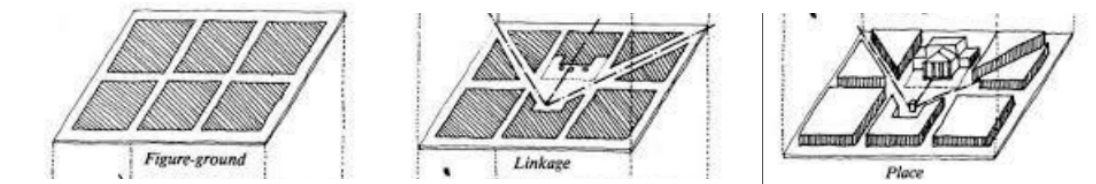
Figure 2 Diagram of urban design theories (Trancik,